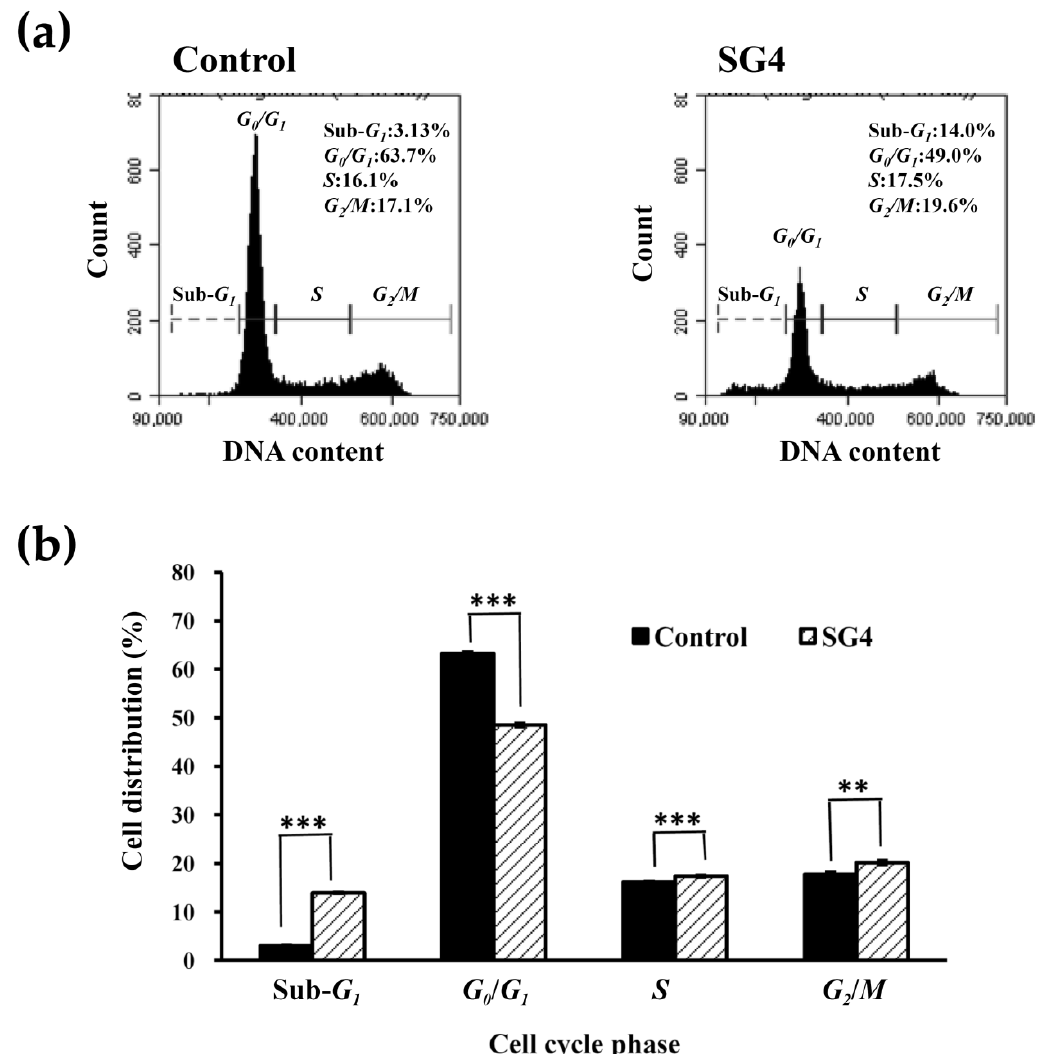
Figure 2. The cell cycle profile of HT-29 cells treated with 200 µ g / mL SG4 for 48 h: ( a ) In the histograms, x axis and y axis denote DNA content and cell counts, respectively. The cell cycle distribution (sub- G 1 , G 0 / G 1 , S , and G 2 / M ) is indicated in each histogram; ( b ) the percentage of sub- G 1 , G 0 / G 1 , S , and G 2 / M cells is presented as determined for ( a ). The experiments were performed in triplicate. ** p < 0.01; *** p < 0.001.